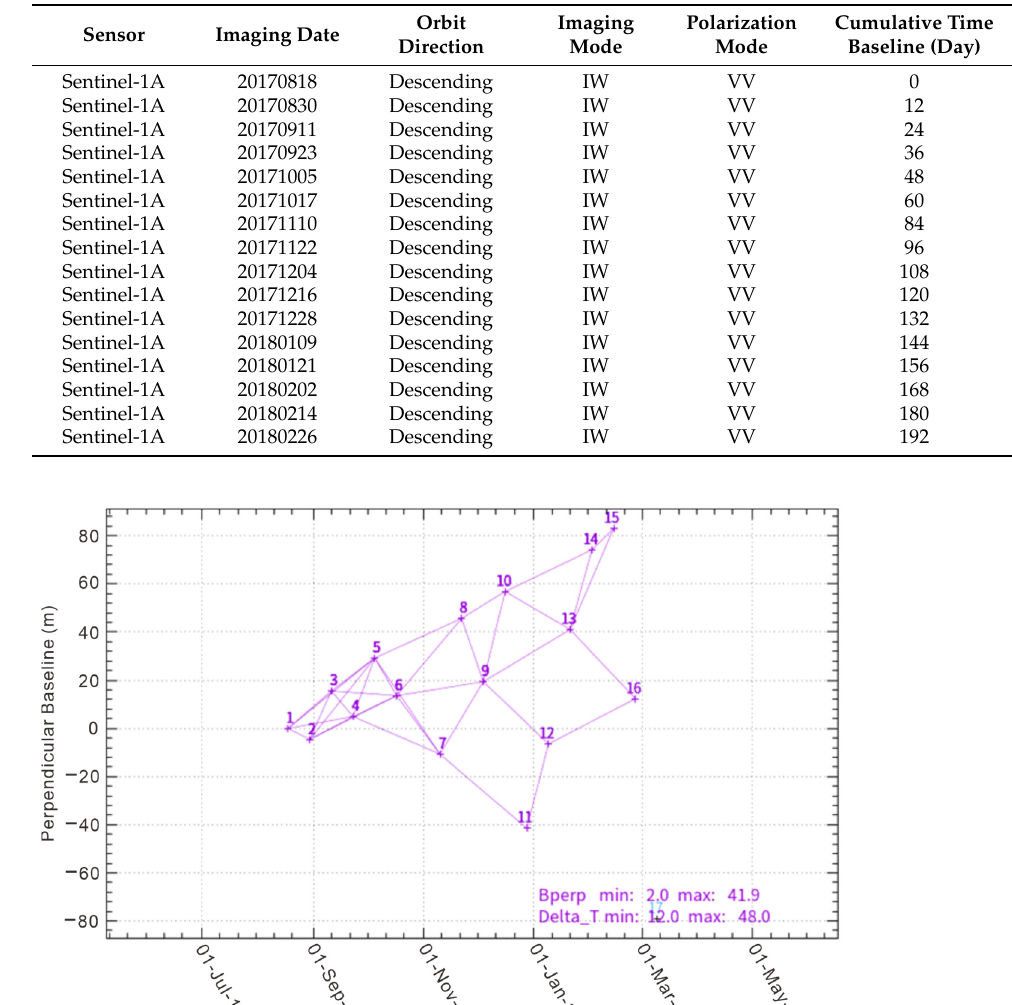
Table 2. Basic information of the SAR data used in the SBAS-InSAR interferogram.